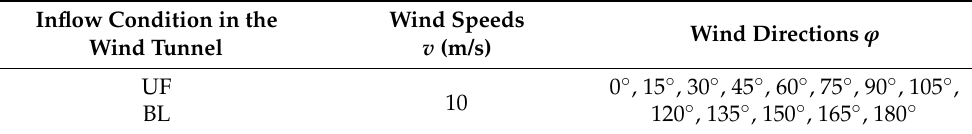
Figure 3. Schematic diagram of wind direction angle in the wind tunnel test. Table 1. Test